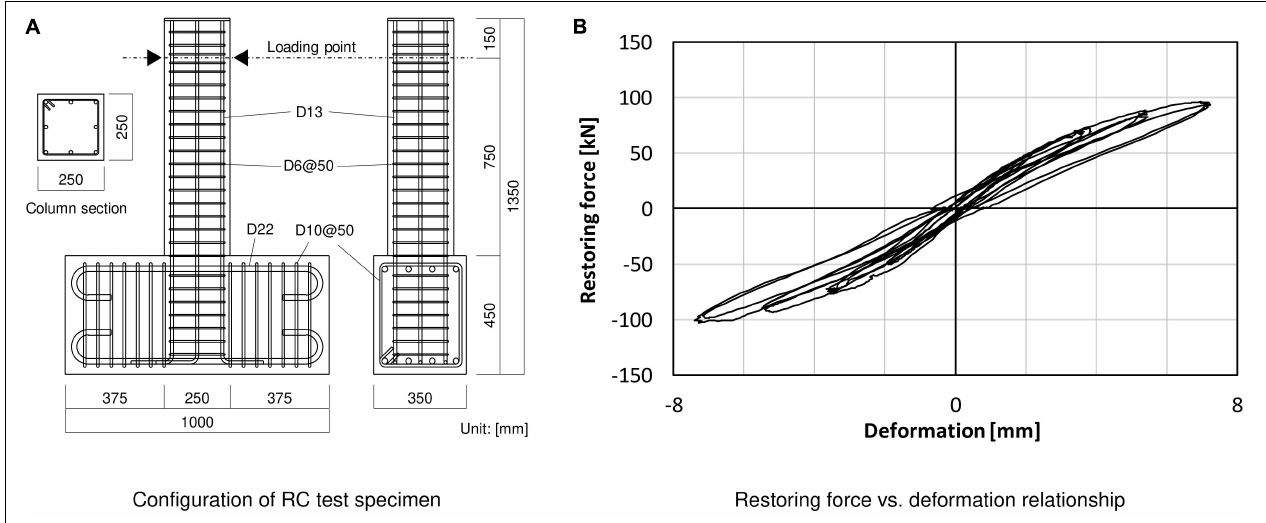
FIGURE 3 | Configuration and static-loading test result of RC column test specimen. (A) Configuration of RC test specimen. (B) Restoring force vs. deformation relationship.